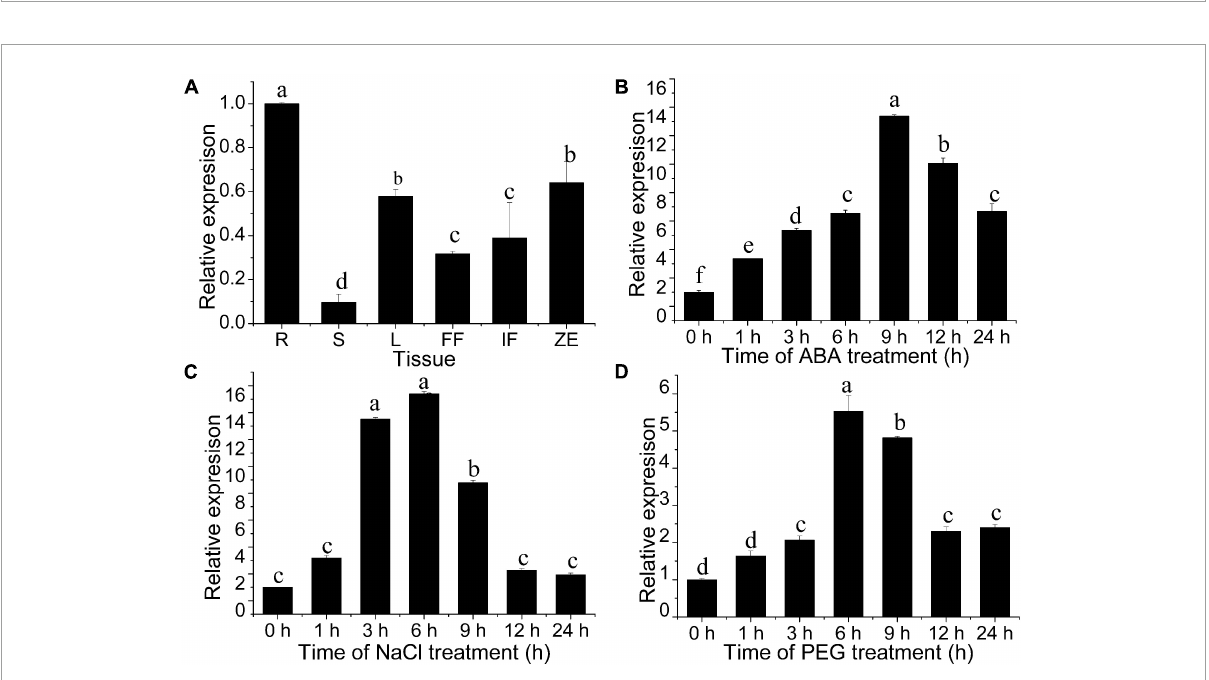
FIGURE4 Expression patterns of JrWOX11 as assessed by qRT-PCR. (A) Spatial and temporal expression of JrWOX11 in different tissues. (B–D) Relative expression of JrWOX11 under 100 µ M ABA, salt (200 mM NaCl) and 10% (w/v) PEG 6000 solution. Error bars = SEM. Statistical differences were analyzed using Student’s t- test, n = 3. Different letters labeled indicate significant differences.